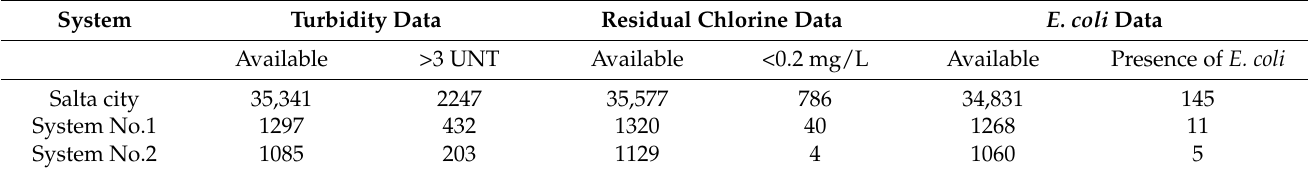
Table 4. Available and deviated data (years